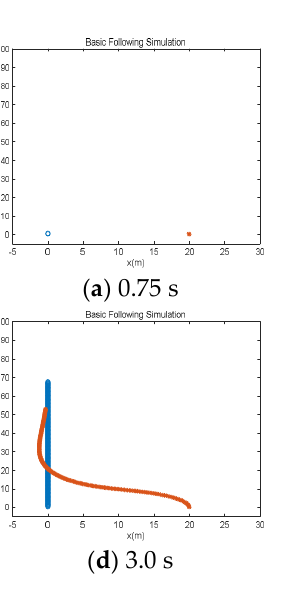
Figure 3. Basic following control simulation results ( k 2 = 2, recorded every 0.75 s). The blue line is the trajectory of the leading vehicle and the red line is the trajectory of the following vehicle. Table 1. Simulation results (angular velocity control coefficient = 4.0, initial distance between the two vehicles = 20 m, facing the same direction)